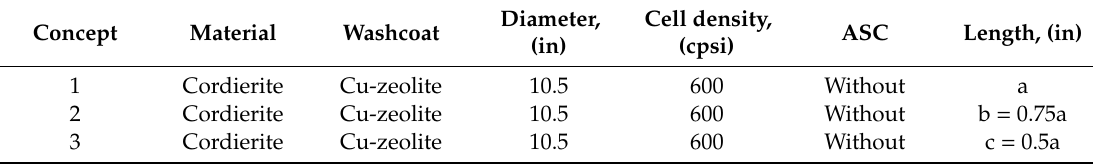
Figure 3. Aftertreatment SCR sizing concepts in the experiments. Table 1. SCR specifications matrix in the experiments.